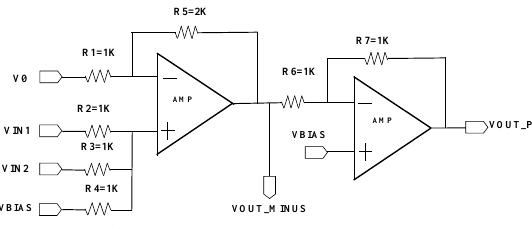
Figure 9. Summator inside our perceptron